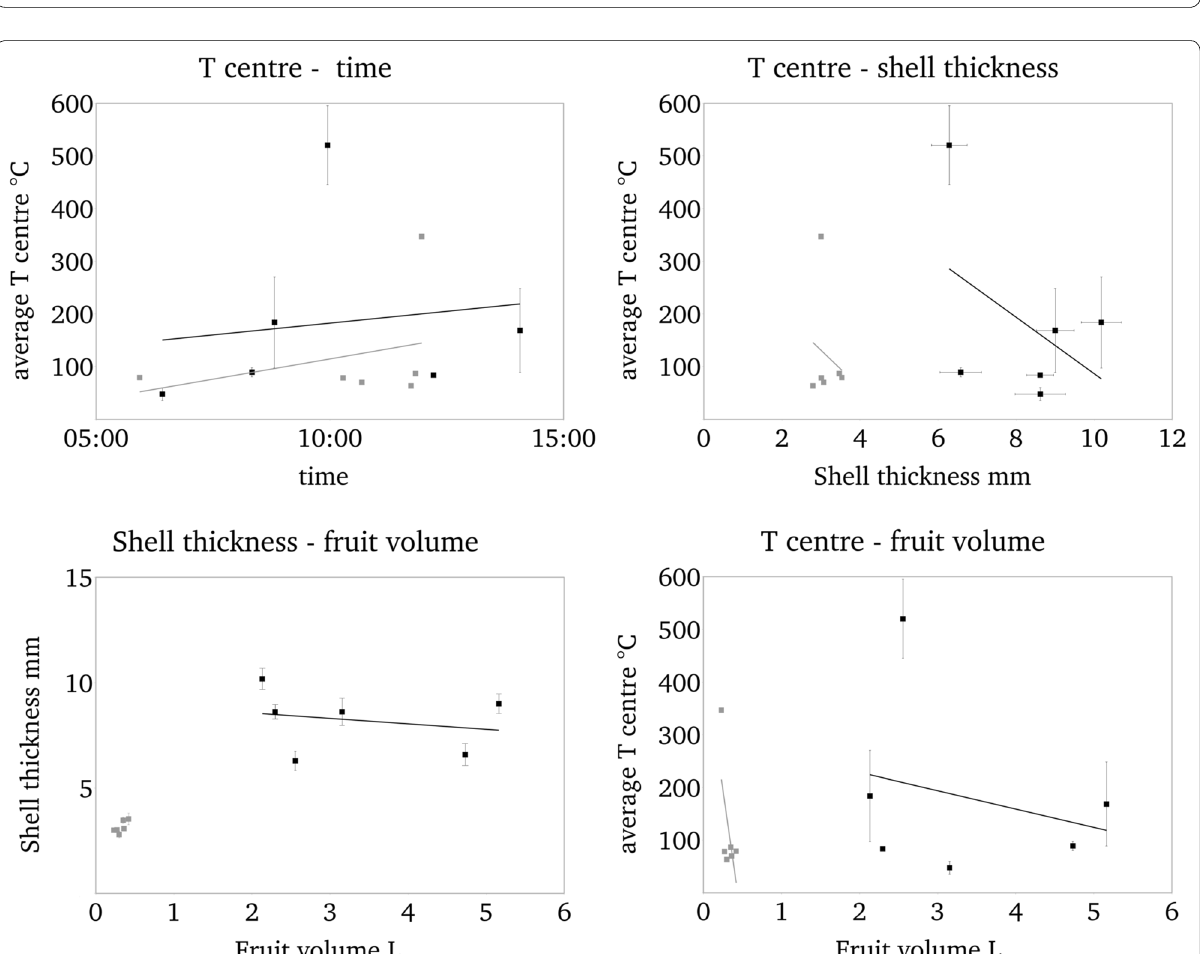
Fig. 5 Correlation of temperature in the centre of fruits, fruit volume, heat exposure time, and shell thickness. Black A. digitata and grey A.